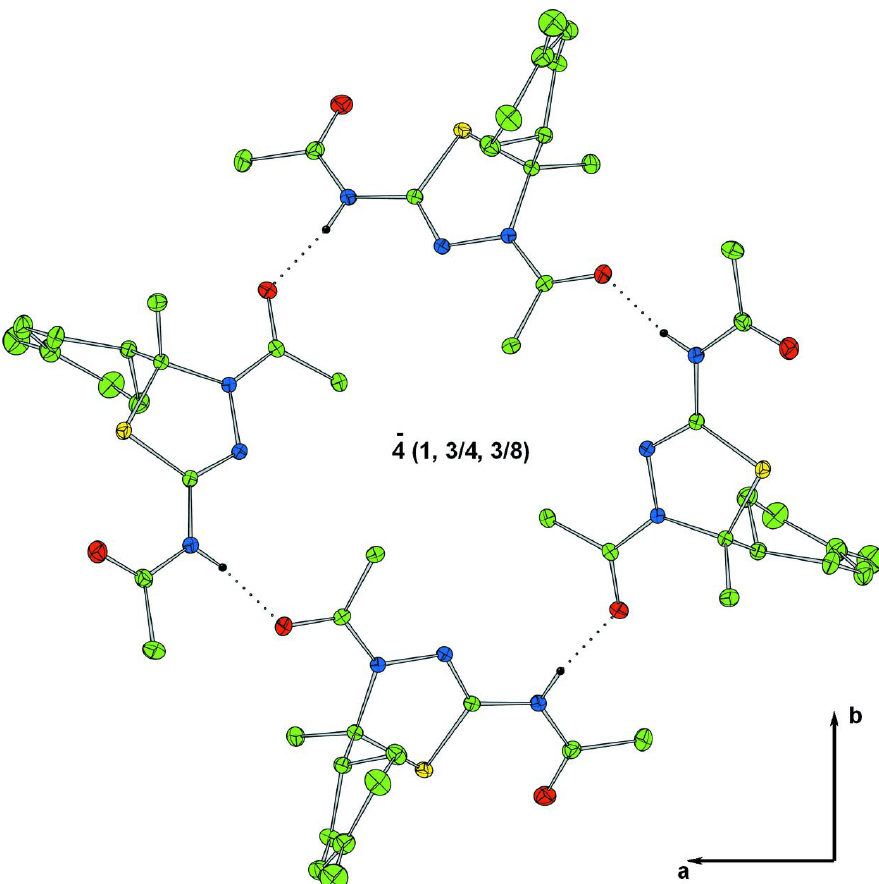
Figure 2 Projection down the c axis, showing the formation of the R 44 (28) motif through N—H···O hydrogen bonds around the fourfold screw axis 4. H atoms not involved in hydrogen bonding have been omitted for